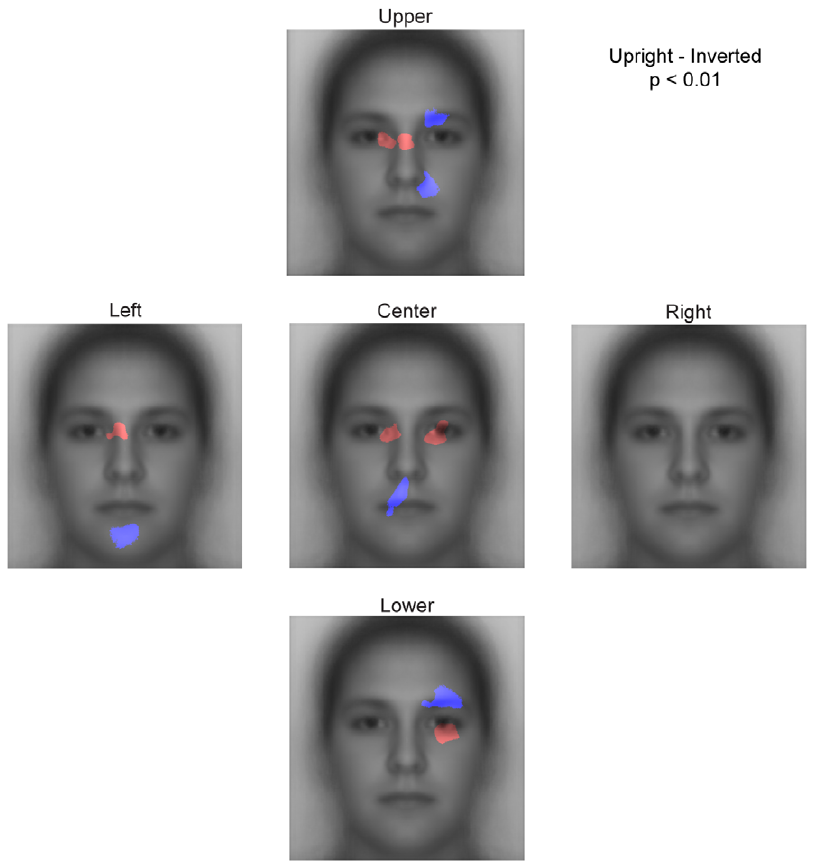
Figure 12. Impact of start position on the comparison of upright and inverted faces. Statistically thresholded maps for the contrast between upright and inverted faces by start position. Regions with p , 0.01 significance for upright faces are shown in red and those for inverted faces are shown in blue. At a coarse scale, the difference is consistent with more fixations to the eyes in upright and toward the lower part of the face in inverted. However, the precise location and extent, particularly of which part of the lower face accrues more fixations in inverted and which part of the eye region accrues more fixations in upright varies with start position.